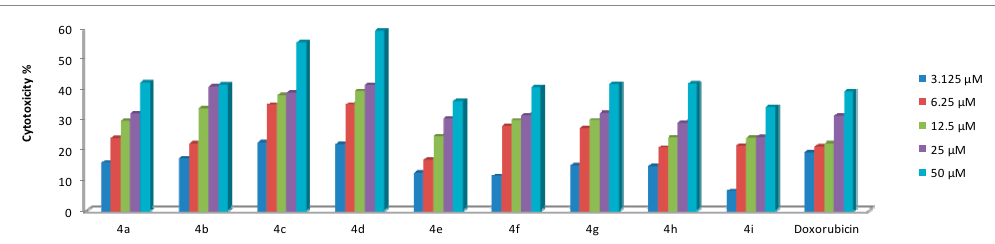
Figure 7. Dose dependent cytotoxic activities of new compounds on RPE-1 human normal cells according to the MTT assay. Table 2. IC 50 of the new compounds against the four human cancer cells as well as one human normal cell types according to the MTT assay.